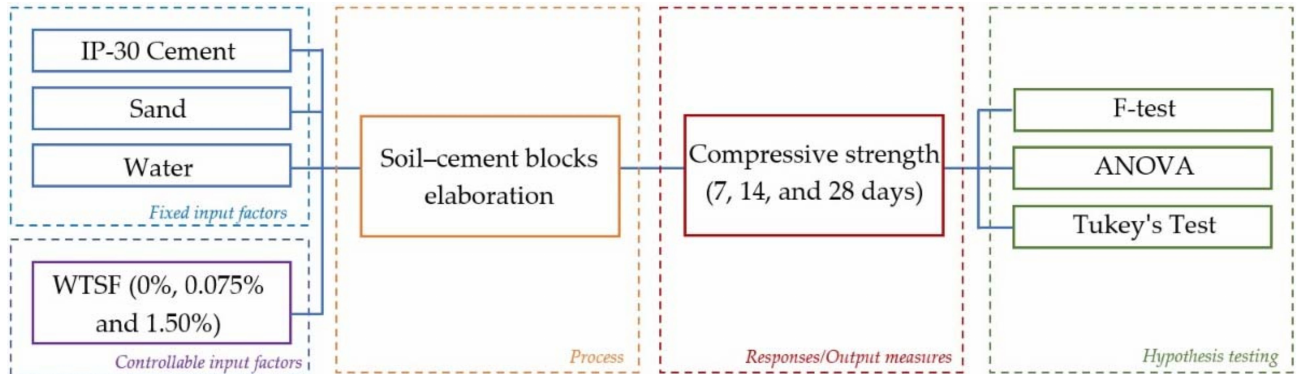
Figure 1. Soil–cement block sample: ( a ) 0.75% WTSF, and ( b ) dimensions.